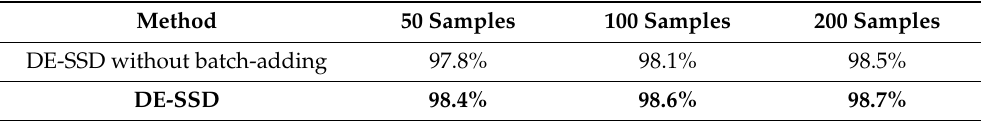
Table 3. Testing results of DE-SSD without batch-adding strategy and DE-SSD on different amounts of labeled